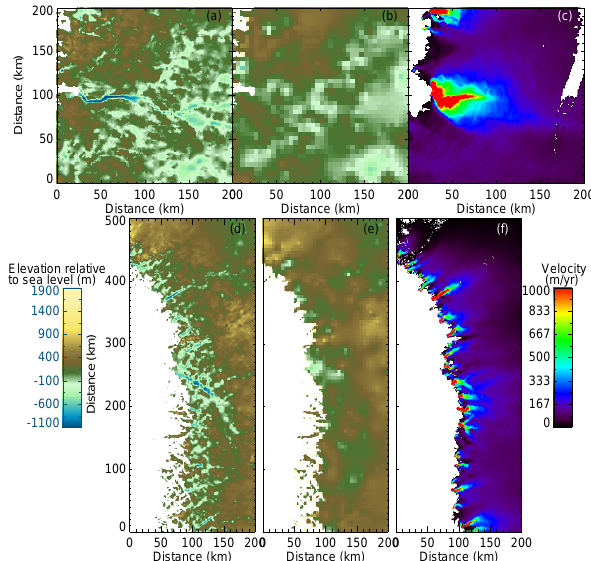
Fig. 4. (a) Bed elevation for Jakobshavn sector from the new DEM, (b) as for (a) but from the old DEM (Bamber et al., 2001b), (c) ice surface velocity from InSAR (Joughin et al., 2010), (d) bed eleva- tion along north-west coast from the new DEM, (e) as for (d) but from the old DEM (Bamber et al., 2001b) and (f) ice surface veloc- ity from InSAR (Joughin et al., 2010). For locations of the regions shown, see Fig. 3.